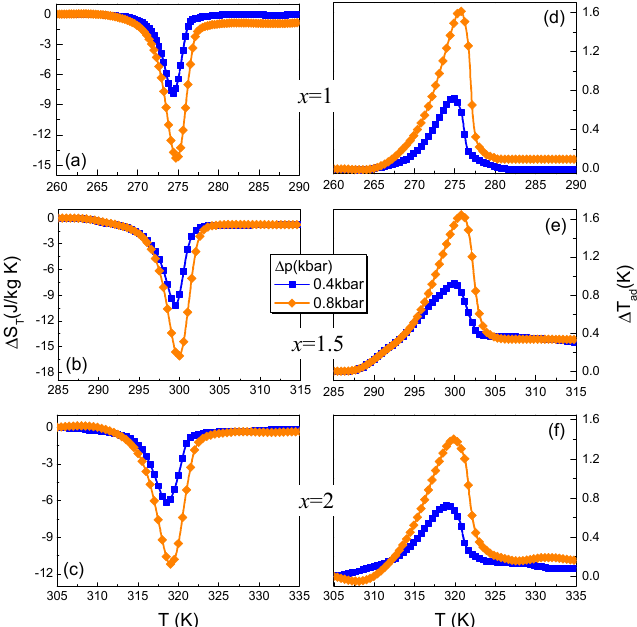
Figure 5. ( a – c ) The isothermal entropy change ( ∆ S T ), as a function of temperature during the forward MT of Co 50 V 34 Ga 16 − x Fe x for the hydrostatic pressure change of 0.4 kbar and 0.8 kbar. ( d – f ) The temperature dependence of the adiabatic temperature change ( ∆ T ad ), obtained at same condition. Figure 6 compare the values of ∆ S T and ∆ T ad for the sample with x = 1.5 to those reported previously in some ferromagnetic, antiferromagnetic, paramagnetic, and ferroelec- tric barrocaloric materials. Under the similar conditions, it is obvious that the barocaloric parameters of Co 50 V 34 Ga 14.5 Fe 1.5 are superior to those obtained in BaTiO 3 [15], La-Fe- Co-Si [8], Gd-Si-Ge [9], PdNMn 3 [38], and a lot of Ni-Mn-based ferromagnetic Heusler alloys [4–6], but they are prominently inferior to some giant barrocaloric compounds, includ- ing Mn 3 GaN [11], MnCoGeB 0.03 [13], (MnNiGe) 0.91 (FeCoGe) 0.09 [14], and the paramagnetic Ni 50 Mn 31.5 Ti 18.5 [39], whose FOMT can bring about a huge volume change. Despite this fact, our studied alloys have many other advantages, such as a controllable transformation temperature, easy preparation, high mechanical strength, and good oxidation